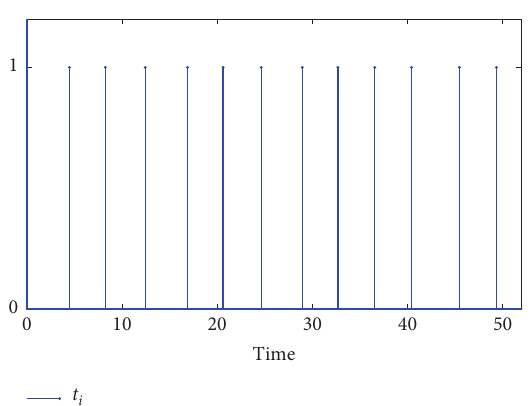
Figure 3: State trajectories x observer-based T-APIC.